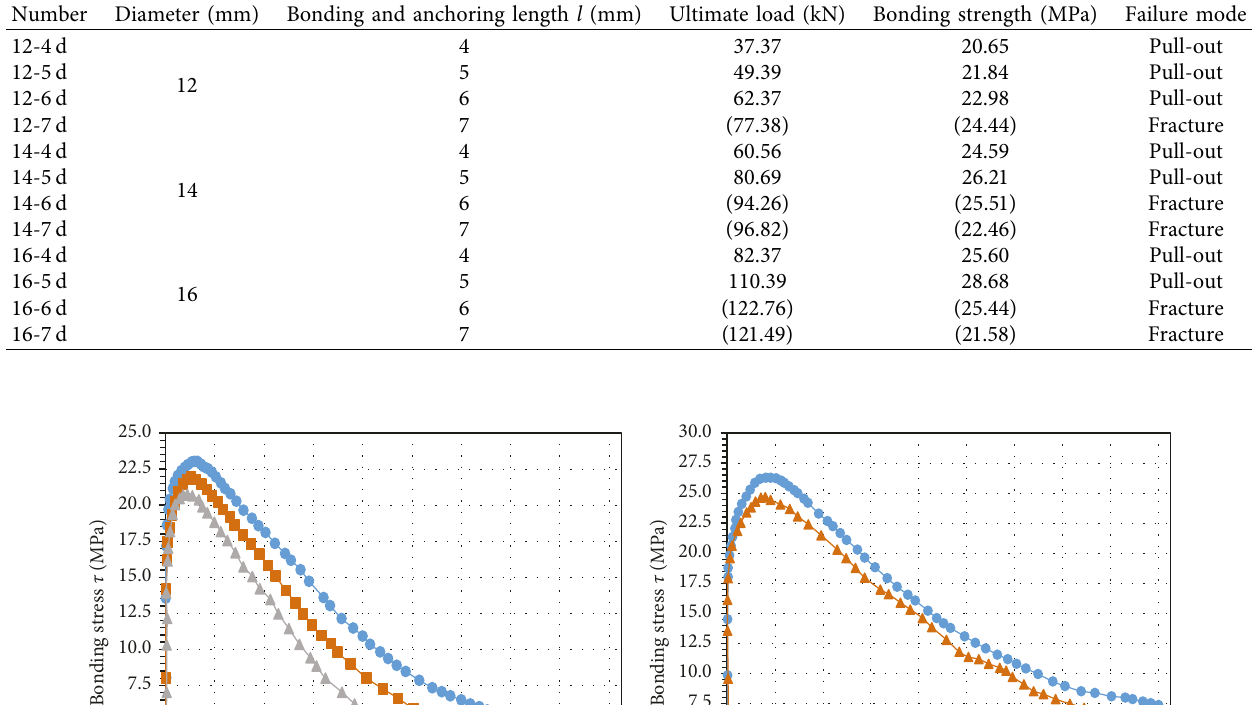
Table 15: Results of pull-out test of steel reinforcement and polyurethane concrete.